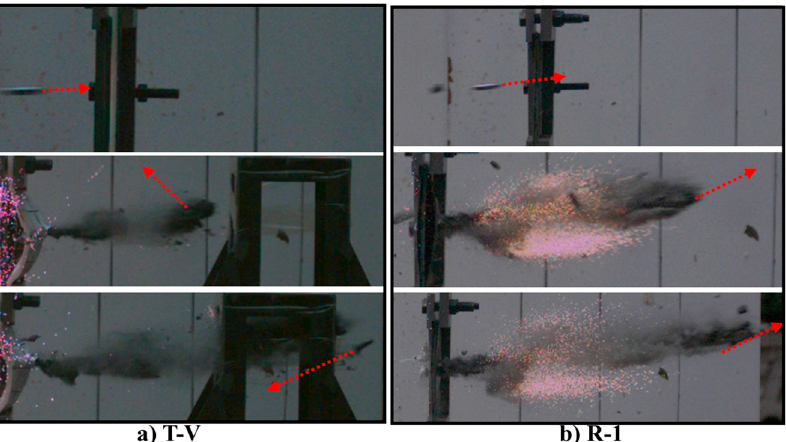
Figure 17. High-speed images of the change of warhead direction during penetration. ( a ) Impact test of T-V. ( b ) Impact test of